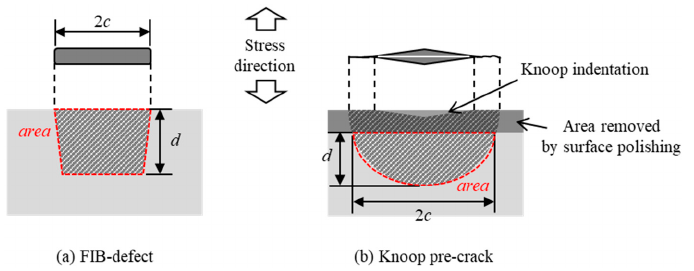
Figure 3. Schematic illustrations of surface defects: ( a ) FIB-defect specimen; ( b ) pre-crack + polished specimen.